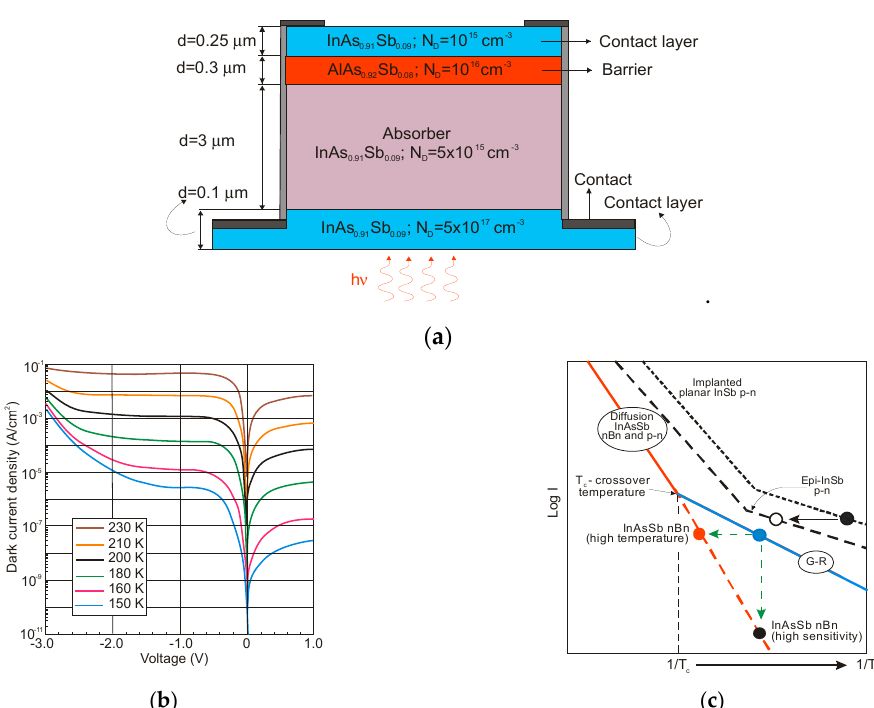
Figure 47. InAsSb/AlAsSb nBn MWIR detector: ( a ) the device structure ([154]), ( b ) dark current density versus voltage for InAs 0.805 Sb 0.195 for selected temperatures 4096 (18 μ m pitch) detectors ( λ cut-off ≈ 4.9 μ m at 150 K) tied together in parallel (after [155]), and ( c ) schematic Arrhenius plot of temperature dependence of the dark current in two type InSb p-n junctions (made by ion-implantation and MBE grown (dashed line). The diffusion and G-R limited portions of the InAsSb curves are also labeled.